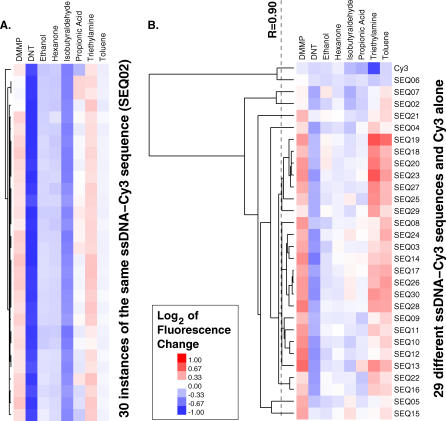
Odor Responses of DNA-Cy3 Sensor Spots Read with Microarray Scanner(A) Thirty SEQ02 control sensors (rows) tested with eight odors (columns). Pairwise Pearson correlation coefficients ranged from 0.91 to 1.00 (mean = 0.98, SD = 0.016).(B) Twenty nine different DNA-Cy3 sensors and Cy3 alone (rows) tested with the same odor test set as (A) (columns). Pairwise correlation coefficients ranged from −0.54 to 0.98 (mean = 0.66, SD = 0.32). Dashed line denotes correlation coefficient of 0.90. Data matrices show log2 transforms of fluorescence change between clean air and odor with graded red colors indicating the degree of fluorescence increase above baseline and blue indicating the degree of decrease. Dendrograms drawn to the same scale. Abbreviations: DMMP, dimethyl methylphosphonate; DNT, dinitrotoluene.